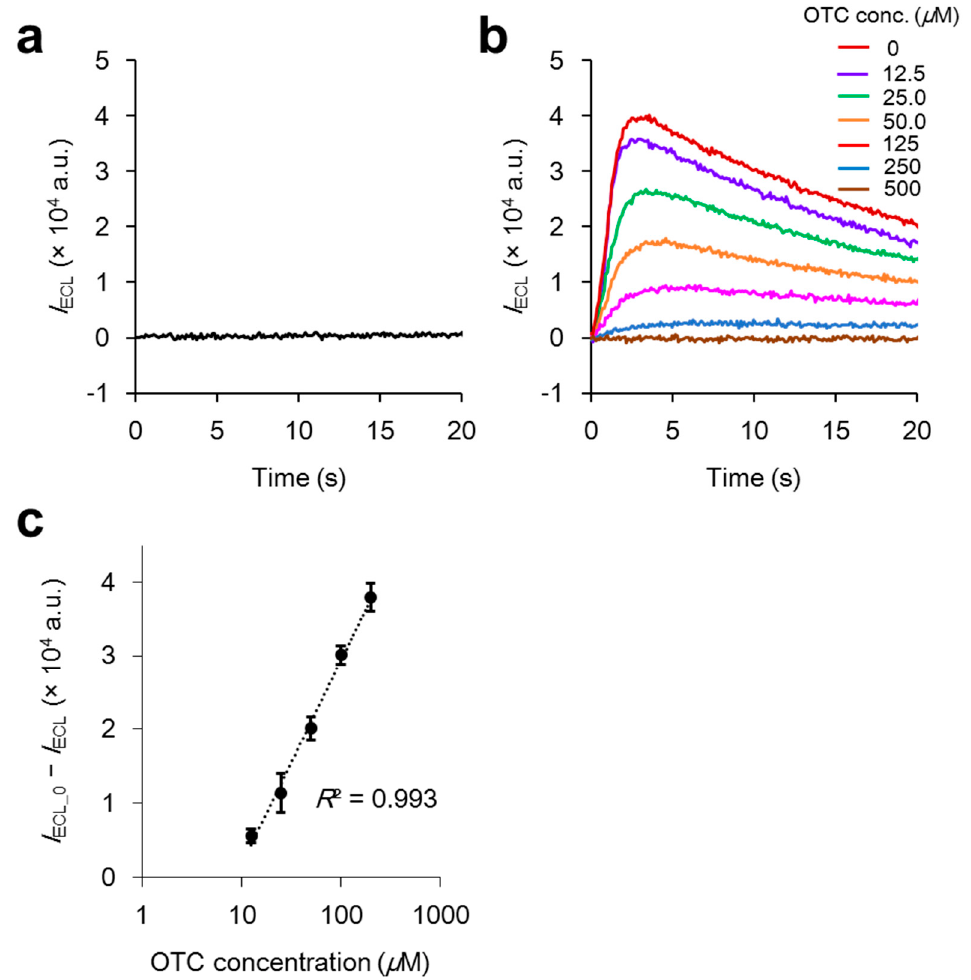
Figure 4. Time courses of ECL with ( a ) Ru(bpy) 32 + and ( b ) Ru-POSS in BE of 0.1 mM Ru(II) complexes and 100 mM TPrA and various concentrations of OTC in 0.20 M PBS buffer (pH 8.8) stirred for 20 min with an ITO electrode at 1.2V vs. Ag/AgCl. ( c ) Standard curve prepared from the data from ( b ) ( I ECL and I ECL_0 represent the maximum ECL intensity in the time course of BE with and without OTC, respectively).